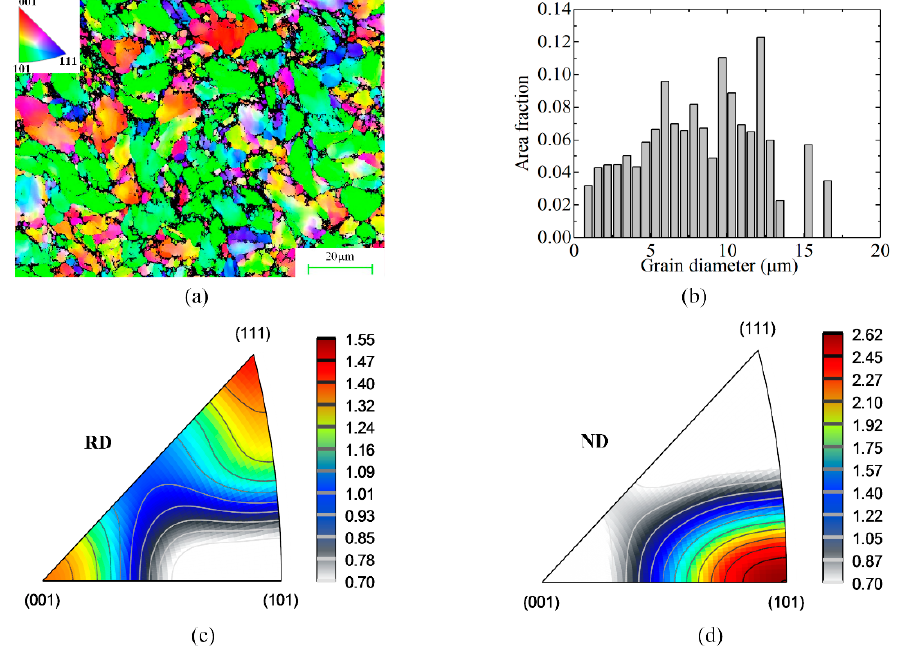
Figure 14. EBSD results: grain size distribution and inverse pole figures (IPFs) of 40Cr bar in Test 1. ( a ) EBSD crystal direction map. ( b ) Grain size distribution. ( c ) IPF of the rolling (cropping) direction. ( d ) IPF of the normal direction.